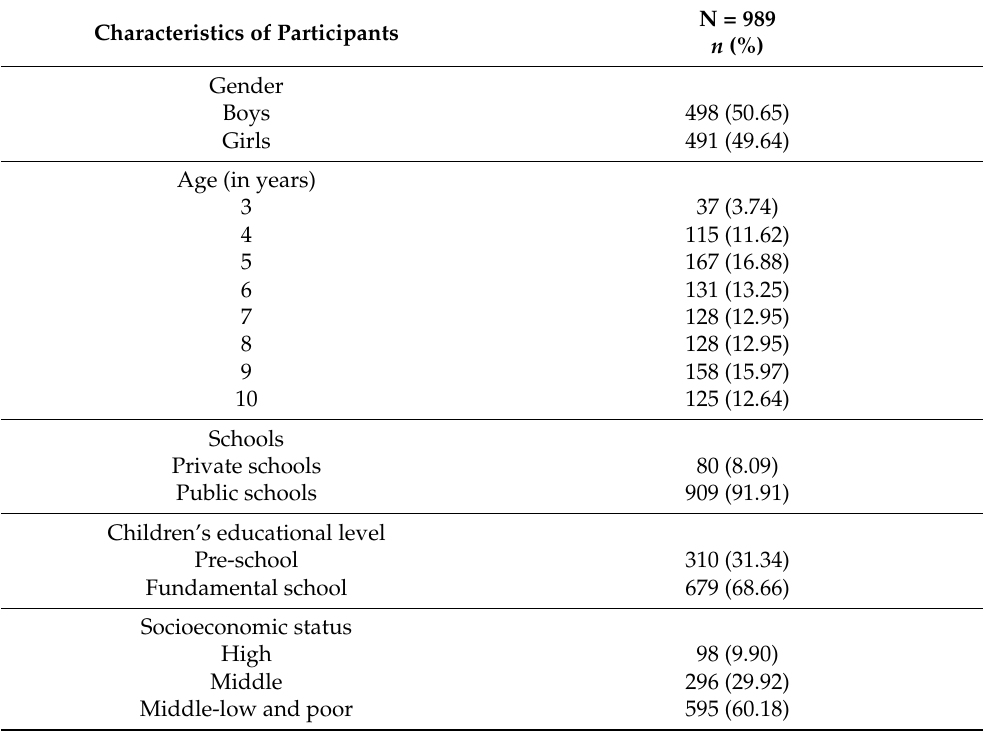
Table 1. Descriptive statistics of participants. Characteristics of